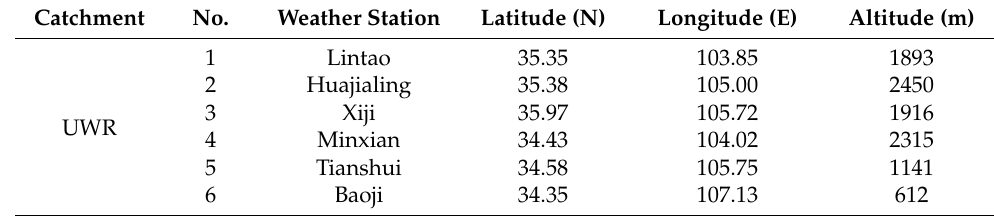
Table 2. Descriptions of the weather stations used in this